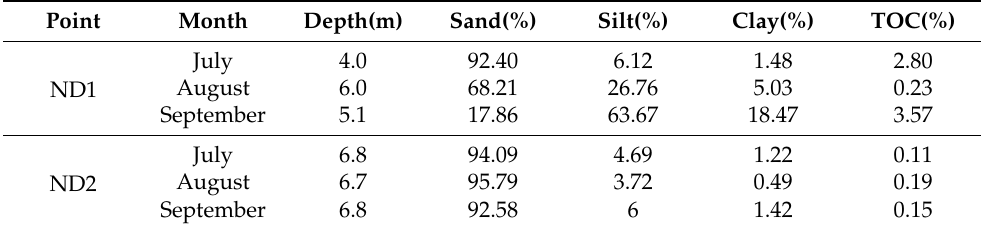
Table 2. Environmental Characteristics of the Study Area.